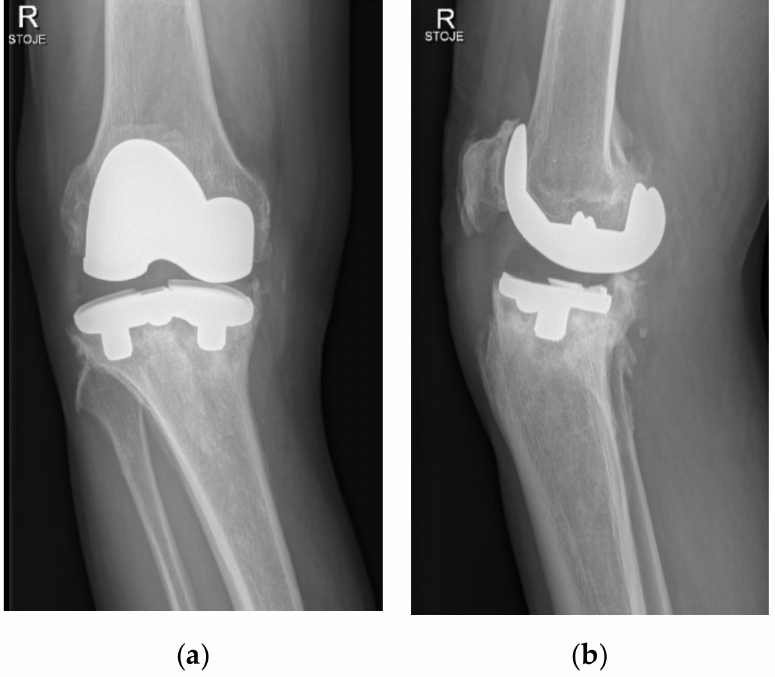
Figure 2. Anteroposterior ( a ) and lateral ( b ) standing radiographs 3.5 years after index operation depicting fracture and displacement of the medial part of the tibial